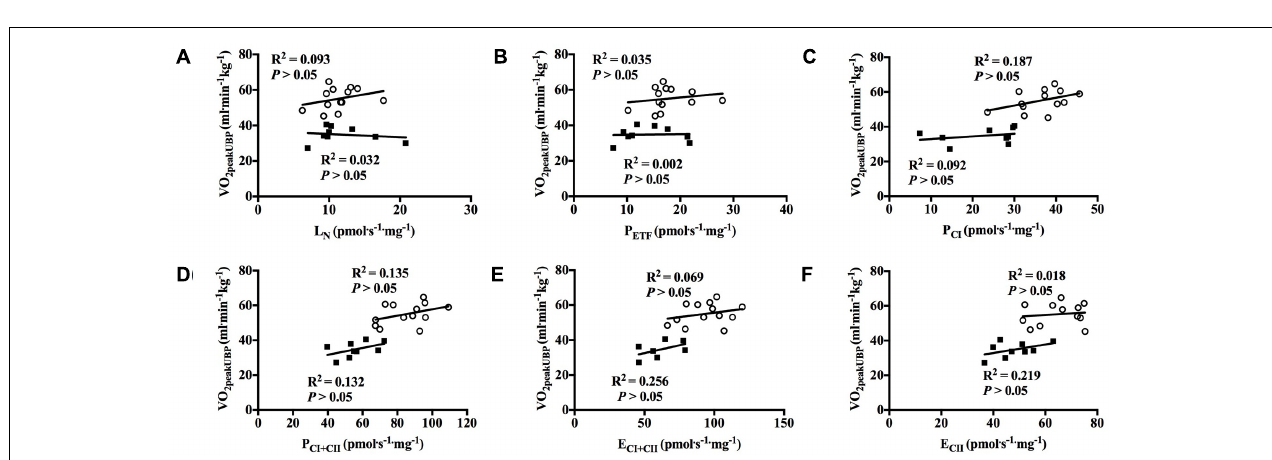
FIGURE 7 | Correlation between peak oxygen uptake (VO 2peak ) in upper body poling and respiratory flux for M. triceps brachii with participants pooled. (A) leak respiration in absence of adenylates (L N ), (B) fatty acid oxidative capacity (P ETF ), (C) complex I respiration (P CI ), (D) complex I and complex II respiration combined (P CI + CII ), (E) electron transfer system capacity (E CI + CII ), and (F) electron transfer system capacity of complex II alone (E CII ). (cid:4) = CON, (cid:13) = XC skiers.